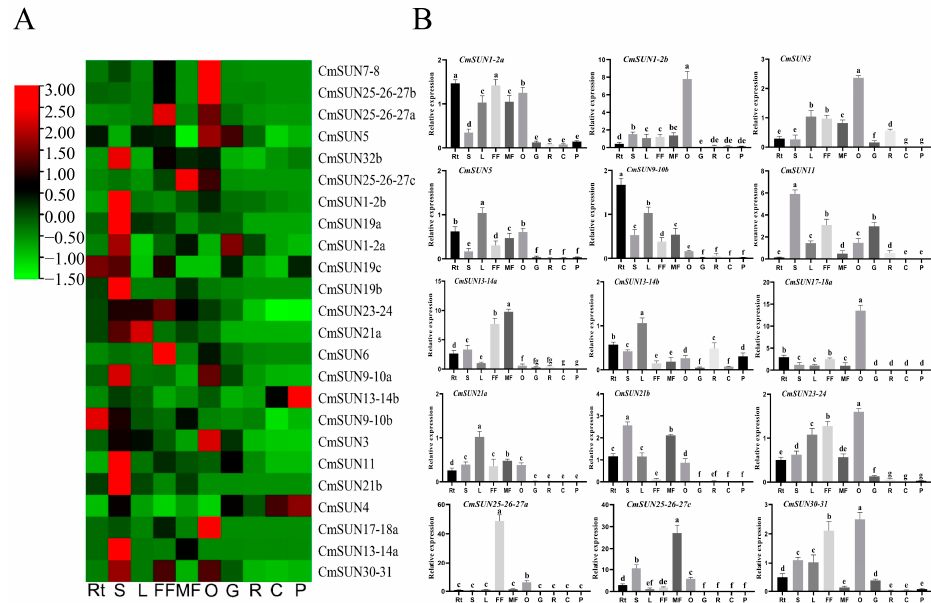
Figure 5. Expression analysis of CmSUN s in melon. ( A ) Heat map of 24 CmSUN gene expression in different melon tissues. ( B ) Expression profiles of part CmSUN genes in melon. Rt, S, L, FF, MF, O, G, R, C, and P represent root, stem, leaf, female flower, male flower, ovary, growing stage, ripening stage, climacteric stage, and post-climacteric stage, respectively. Three biological replicates and three technique replicates were performed for each qRT-PCR analysis. ‘a–g’ indicates the significance difference in the tissues.